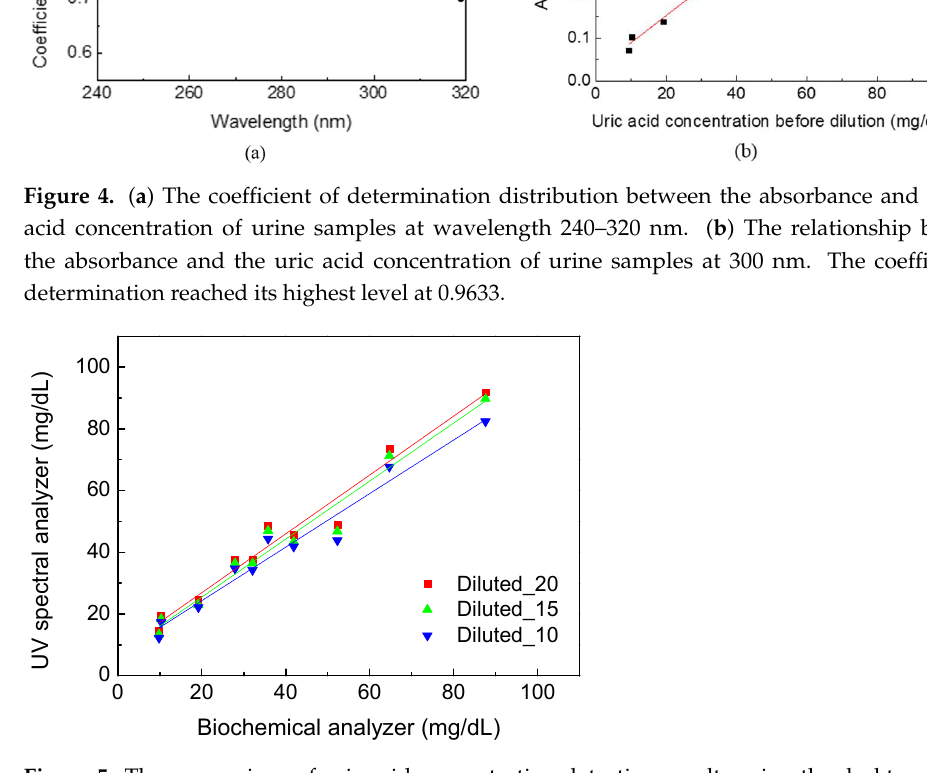
Figure 5. The comparison of uric acid concentration detection results using the desktop spectral analyzer with respect to the biochemical analyzer. The blue (Diluted_10) data represent the R 2 of 0.9571, whereas green (Diluted_15) and red (Diluted_20) data represent the R 2 of 0.9605 and 0.9630, respectively.